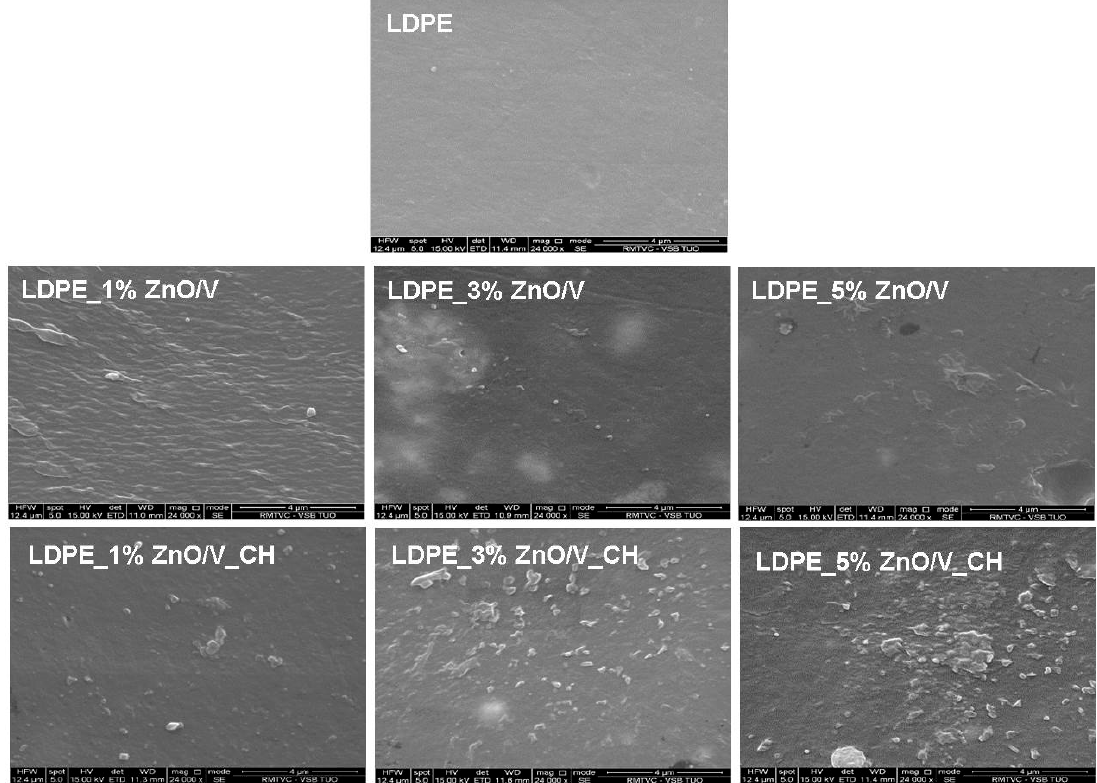
Figure 6. SEM images of the natural LDPE surface and LDPE_1% ZnO / V, LDPE_3% ZnO / V, LDPE_5% ZnO / V, LDPE_1% ZnO / V_CH, LDPE_3% ZnO / V_CH and LDPE_5% ZnO / V_CH nanocomposite surfaces.